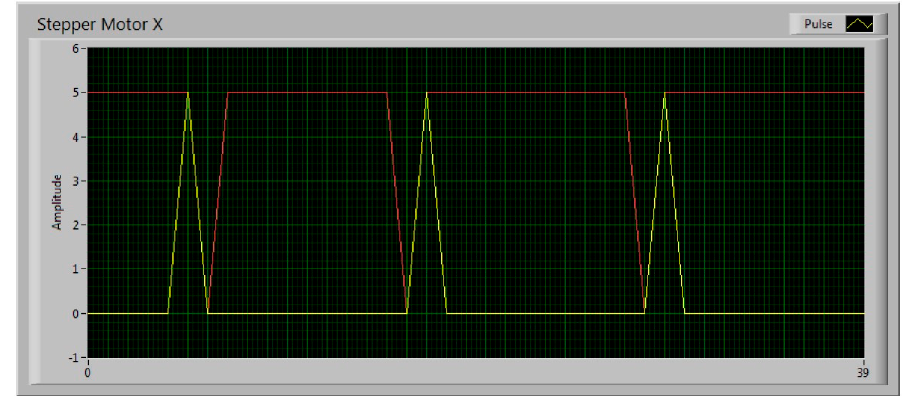
Figure 9. Control signal versus time for stepper motor on the x axis to generate the 5 mm × 5 mm motion pattern.